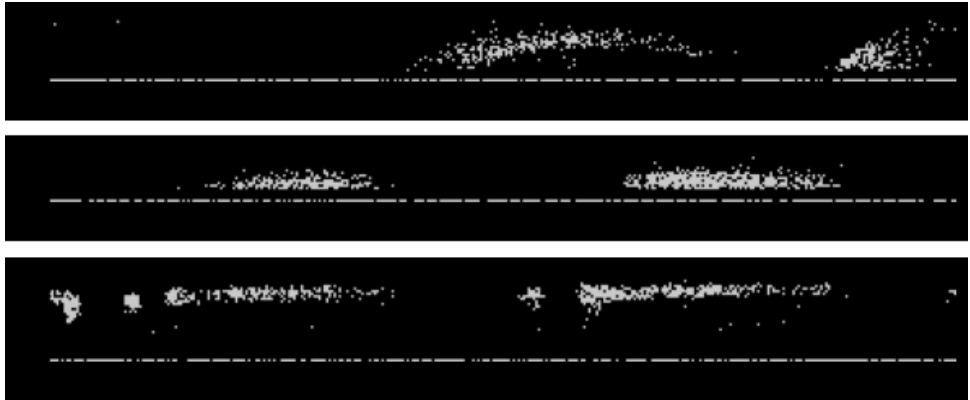
Figure 5. Data from Figure 4 after removal of datapoints below base mode